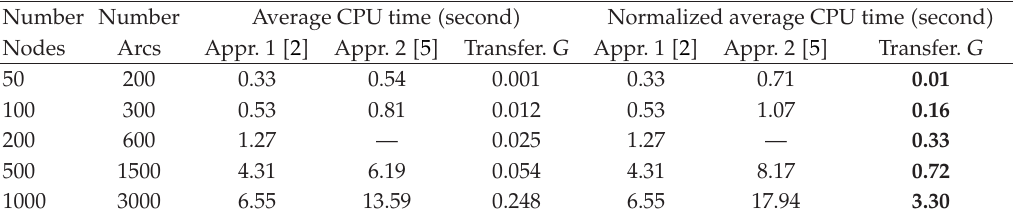
Table 5: Comparative performances of approaches on di ff erent instances of the